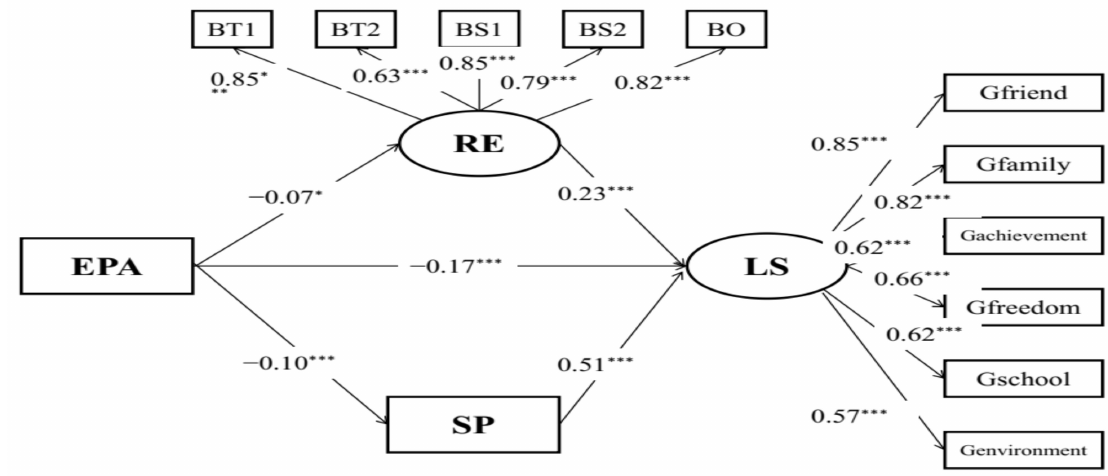
Figure 4. Mediation model of physical abuse, life satisfaction, resilience, and social support.